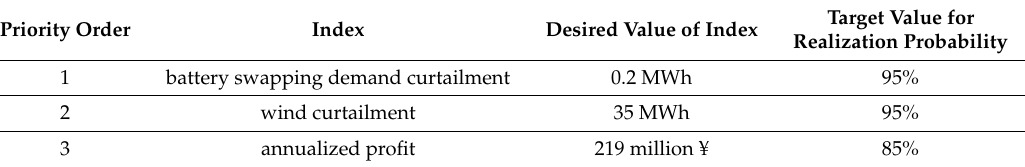
Table 2. The joint system operating indices and the target values for their realization